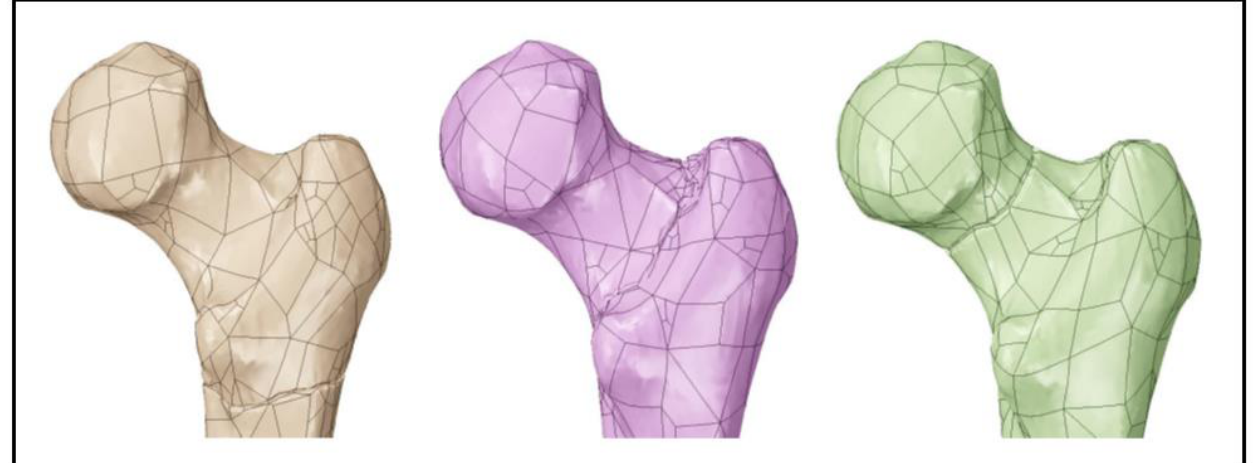
Figure 4. Femur model with a subtrochanteric fracture ( left ), intertrochanteric fracture ( middle ), and intracapsular fracture ( right ). Reprinted from Ref. [21].